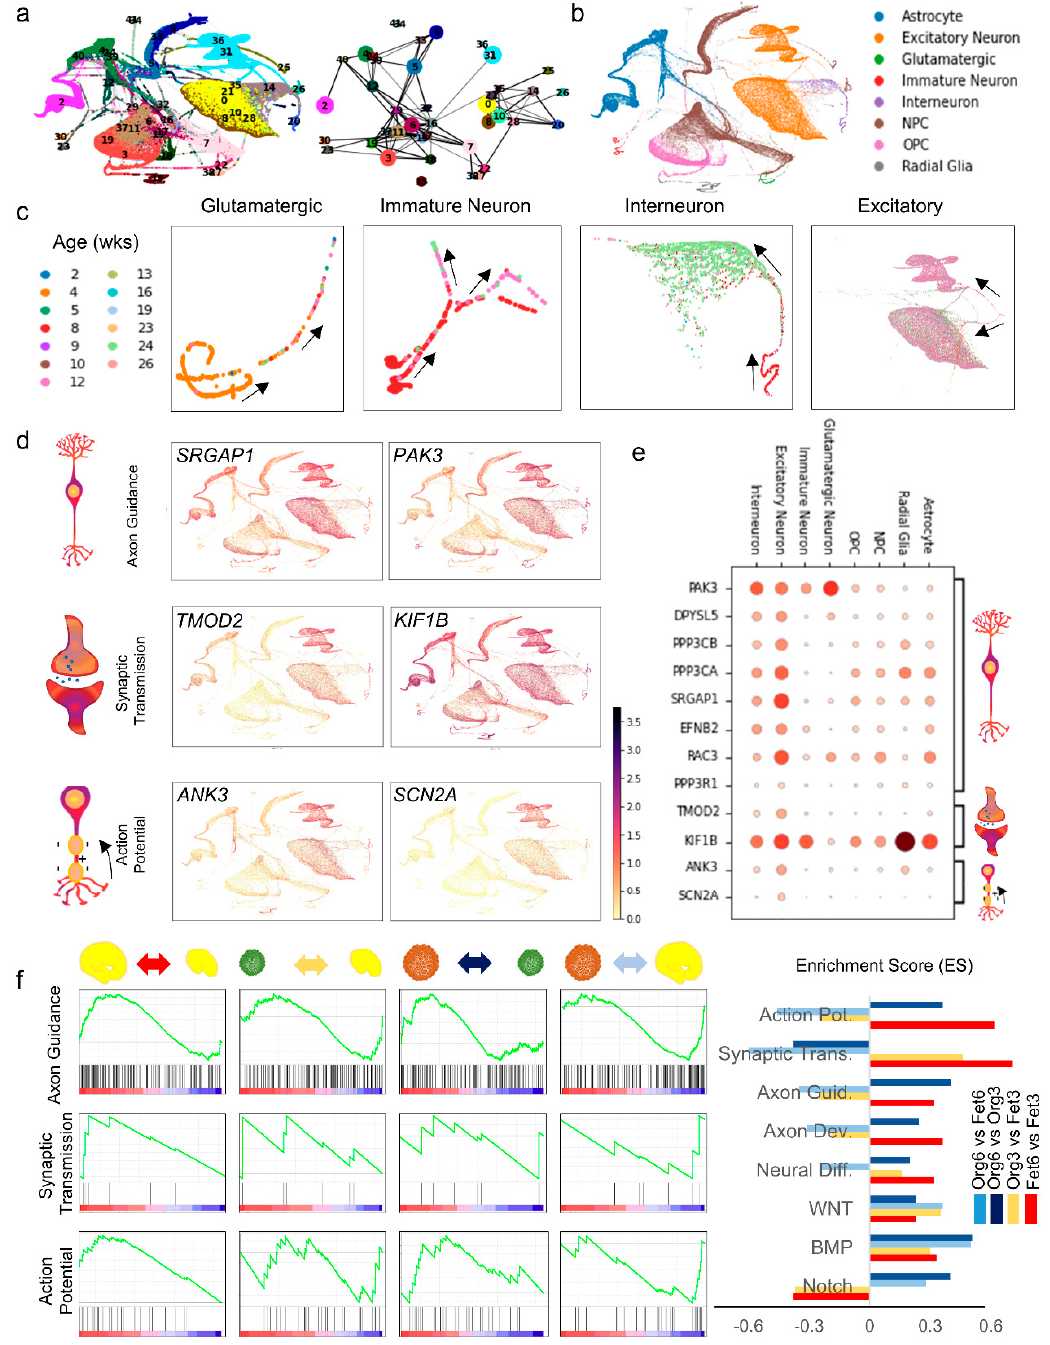
Figure 3. Cellular trajectories and cell-type-specific developmental paths during organoid maturation and expression pattern of neuronal function associated genes. ( a ) Force directed map of single cells showing cellular trajectories and PAGA representing a coarse-grained graph of inferred connectivity among clusters. ( b ) Cellular trajectories grouped by cell-type. Each dot represents a single cell, colored by assigned cell-type. ( c ) Cell-type-specific developmental trajectory in glutamatergic neurons, immature neurons, interneurons, and excitatory neurons across timepoint of 1–26 weeks. Visualization of expression of functional genes associated with axon guidance, synaptic transmission, and neuronal action potential on ( d ) cellular trajectories and ( e ) dot plot. ( f ) Enrichment plot profile of the running enrichment score (ES) and positions of gene set members on the rank ordered list for axon guidance, synaptic transmission, and action potential gene sets. From left to right, comparisons are as following: Fet6 vs. Fet3 (comparison denoted by red), Org3 vs. Fet3 (comparison denoted by yellow), Org6 vs. Org3 (comparison denoted by dark blue), Org6 vs. Fet3 (comparison denoted by light blue). The graph on the farther right depicts the enrichment score in each pathway gene set across groups, coded by the color of each comparison